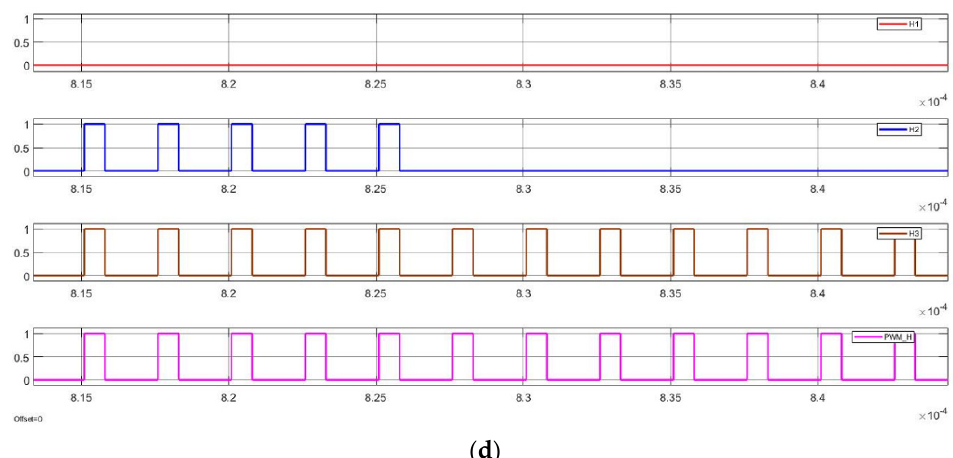
Figure 6. ( a ) Outputs after AND blocks and the final voter when module 1 is forced to output 10% duty to emulate a sudden change in pulse duration. ( b ) Outputs after AND blocks and the final voter when module 2 is also forced to output 10% duty to emulate a sudden change in pulse duration. ( c ) Outputs after AND blocks and the final voter when module 1 is forced to output 80% duty to emulate a sudden change in pulse duration. ( d ) Outputs after AND blocks and the final voter when module 2 is also forced to output 80% duty to emulate a sudden change in pulse duration.